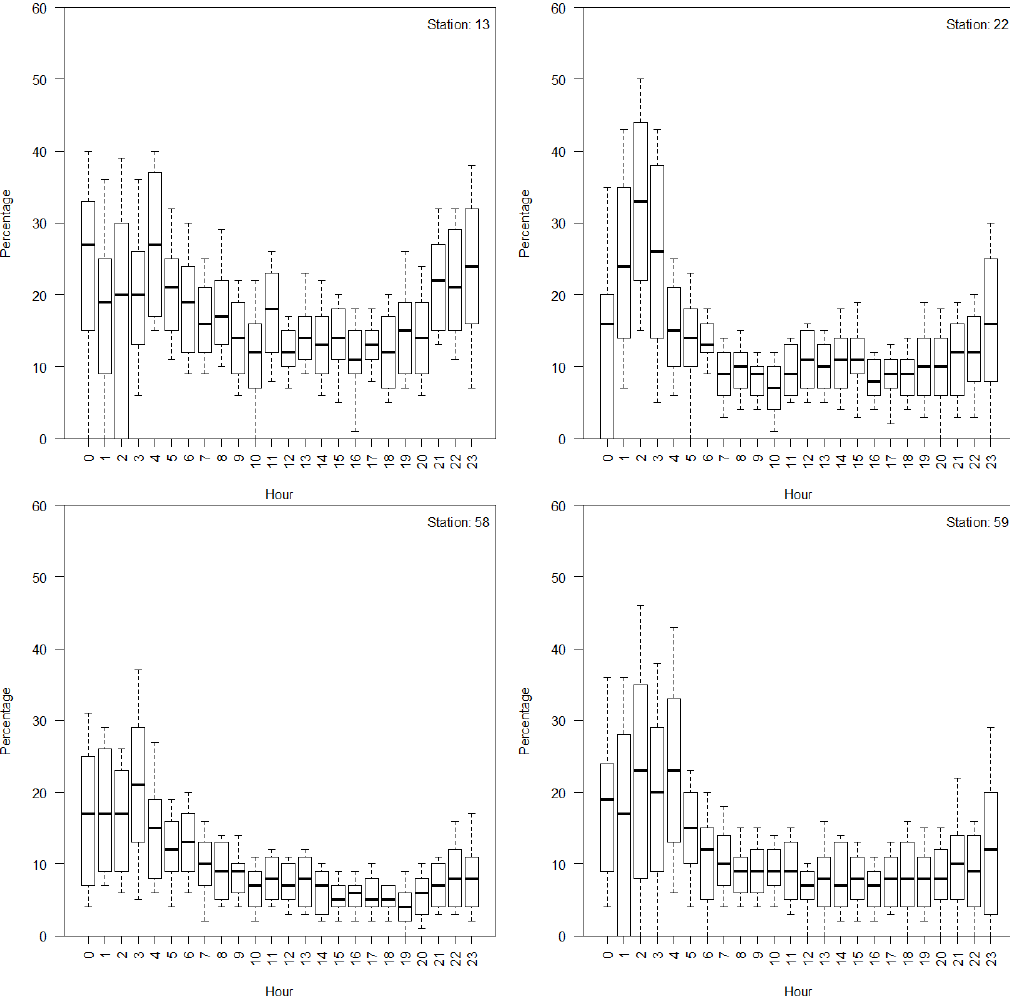
Figure 7: Percentage of category 11 vehicles with the exceeded gross weight in subsequent hours of the day of the measurement period for particular HS-WIM